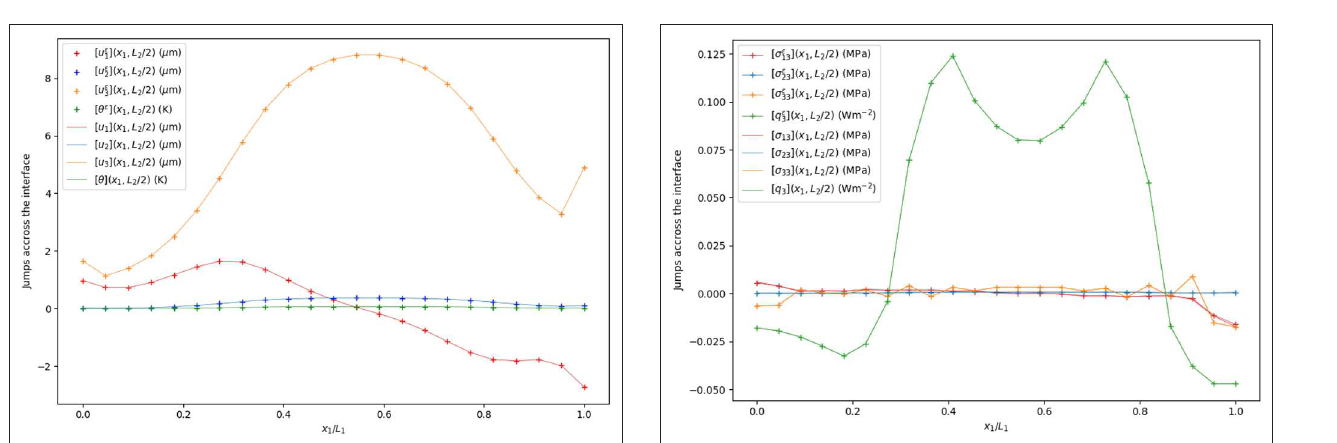
FIGURE 16 | Jumps of the displacement field, temperature (left) , traction vector, and thermal flux (right) across the interface on a line along the x 1 axis, with ε/ h = 0.04.